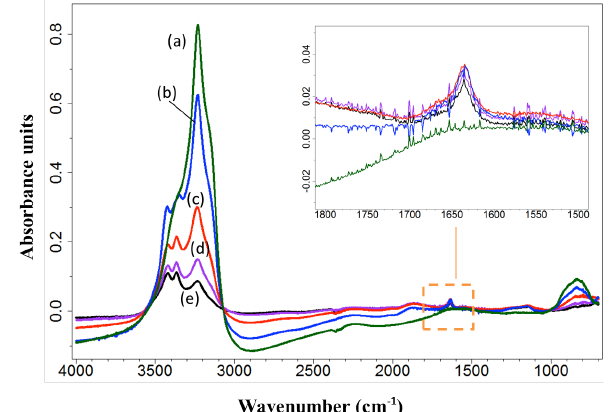
Fig. 1. IR transmission spectra of a pure ice film before (a) and after doping with gaseous HCl at 170K at a typical dose of 1–2 × 10 17 molecules. Spectra (c) , (d) and (e) have been collected in four scans each at 1cm − 1 resolution during film evaporation at increasing temperature under SFR (stirred flow) conditions. No offset has been introduced in order to facilitate the quantitative comparison between spectra.